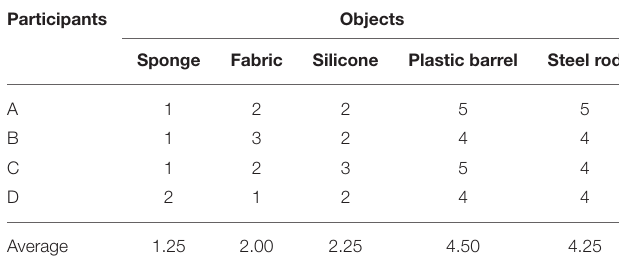
TABLE 3 | Recognition test